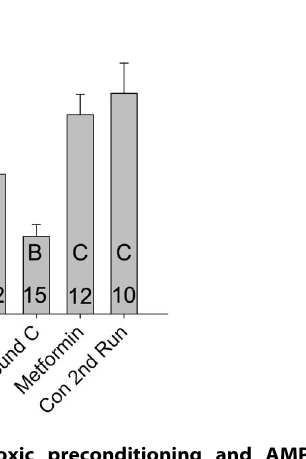
Figure 7. Anoxic preconditioning and AMPK activation is protective against subsequent anoxic events. Animals were submerged in water and the time until they entered a coma state was measured. Preinjection with 10 m L of 1 mM Compound C shortened the time until coma, and metformin preinjection (10 m L, 500 mM) prolonged the animal’s ability to remain active in anoxia. A preconditioning effect was found, in that animals that had recovered for one hour from a previous water submersion showed increased time to coma on subsequent anoxia. The preconditioning effect was similar to preinjection with metformin. Statistical significance is denoted by differing letters (P , 0.05).